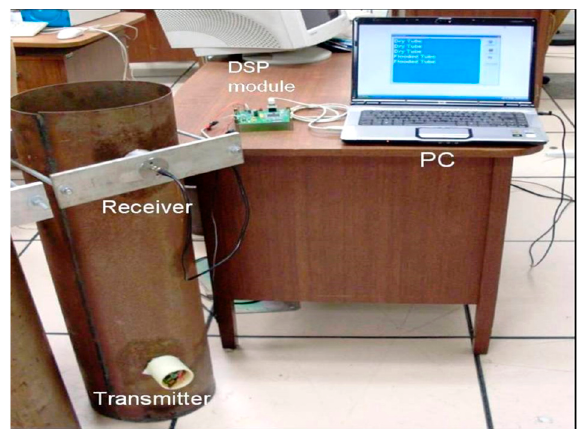
Figure 6. Experiment setup using a hollow steel pipe, 1.5 m × 270 mm × 2 mm, a PPM transmitter, and a DSP instrumentation receiver connected to a PC via USB